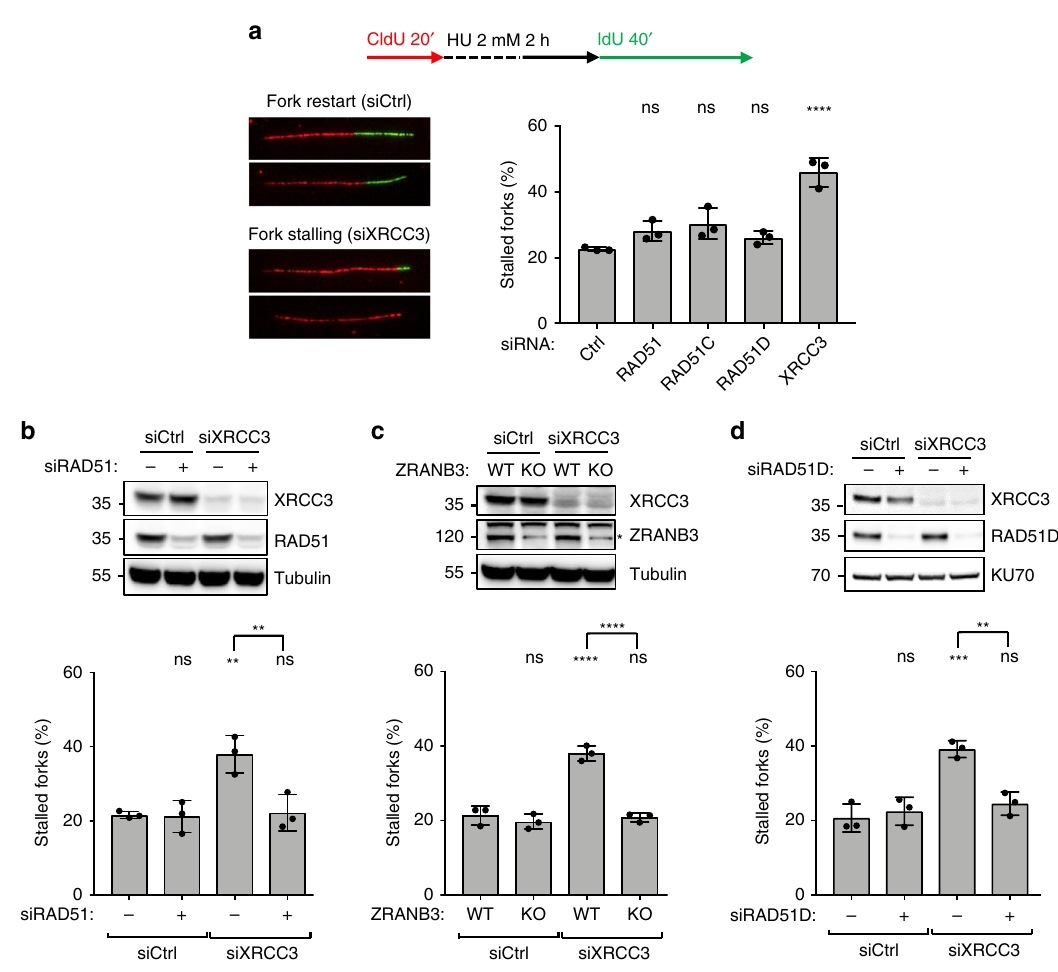
Fig. 4 CX3 complex promotes reversed fork restart in U2OS cells. a DNA fi ber analysis of U2OS cells transfected for 24 – 48 h (24 h for RAD51 , 48 h for all the other genes) with a control siRNA (Ctrl) or with siRNAs targeting RAD51 , RAD51C , RAD51D , and XRCC3 to investigate replication fork restart upon HU. Top: schematic CldU/IdU pulse-labeling protocol to evaluate fork restart upon HU treatment (2 mM, 2 h). Bottom-left: representative stalled and restarting forks. Bottom-right: frequency of fork stalling for each genetic condition. In a – d , the graph-bar depicts mean and SD from three independent experiments. Statistical analysis: one-way ANOVA followed by Bonferroni test; ns not signi fi cant; **** p -value < 0.0001. b DNA fi ber analysis of U2OS cells double transfected with a control siRNA (Ctrl) or with a siRNA targeting XRCC3 (48 h) or RAD51 (24 h) to investigate replication fork restart upon HU treatments; labeling protocol as in a . Top: levels of indicated proteins, assessed by western blot; Tubulin, loading control. In b and d multiple gels/blots were processed in parallel, ensuring equal and comparable loading across gels. Bottom: frequency of fork stalling. ns not signi fi cant; ** p -value = 0.0068 (1 versus 3) and 0.0087 (3 versus 4). c DNA fi ber analysis of wild-type (WT) or ZRANB3 Knock-Out (KO) U2OS cells transfected with a control siRNA (Ctrl) or with siRNAs targeting XRCC3 (48 h) to investigate replication fork restart upon HU treatments; labeling protocol as in a . Top: indicated protein levels, assessed by western blot; Tubulin, loading control; asterisk, speci fi c band. Bottom: frequency of fork stalling. ns not signi fi cant; **** p -value < 0.001. d DNA fi ber analysis of U2OS cells double transfected with a control siRNA (Ctrl), with siRNAs targeting XRCC3 (48 h) or RAD51D (60 h) to investigate replication fork restart upon HU treatments; labeling protocol as in a . Top: indicated protein levels, assessed by western blot; KU70, loading control. Bottom: frequency of fork stalling. ns not signi fi cant; ** p -value = 0.0024; *** p- value = 0.0007. Source data for a – d are provided in the Source Data fi